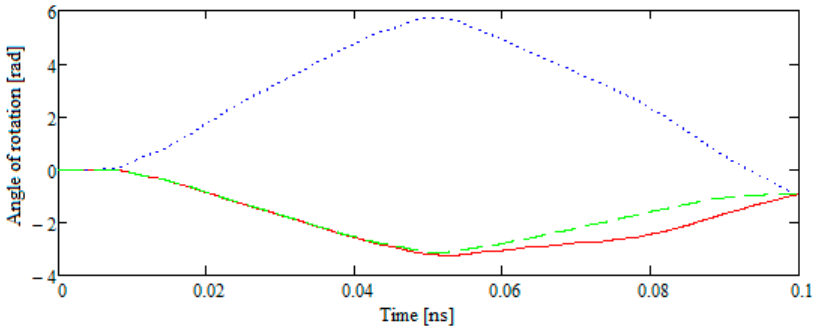
Figure 5. Changes in the angles of rotation of these discs.